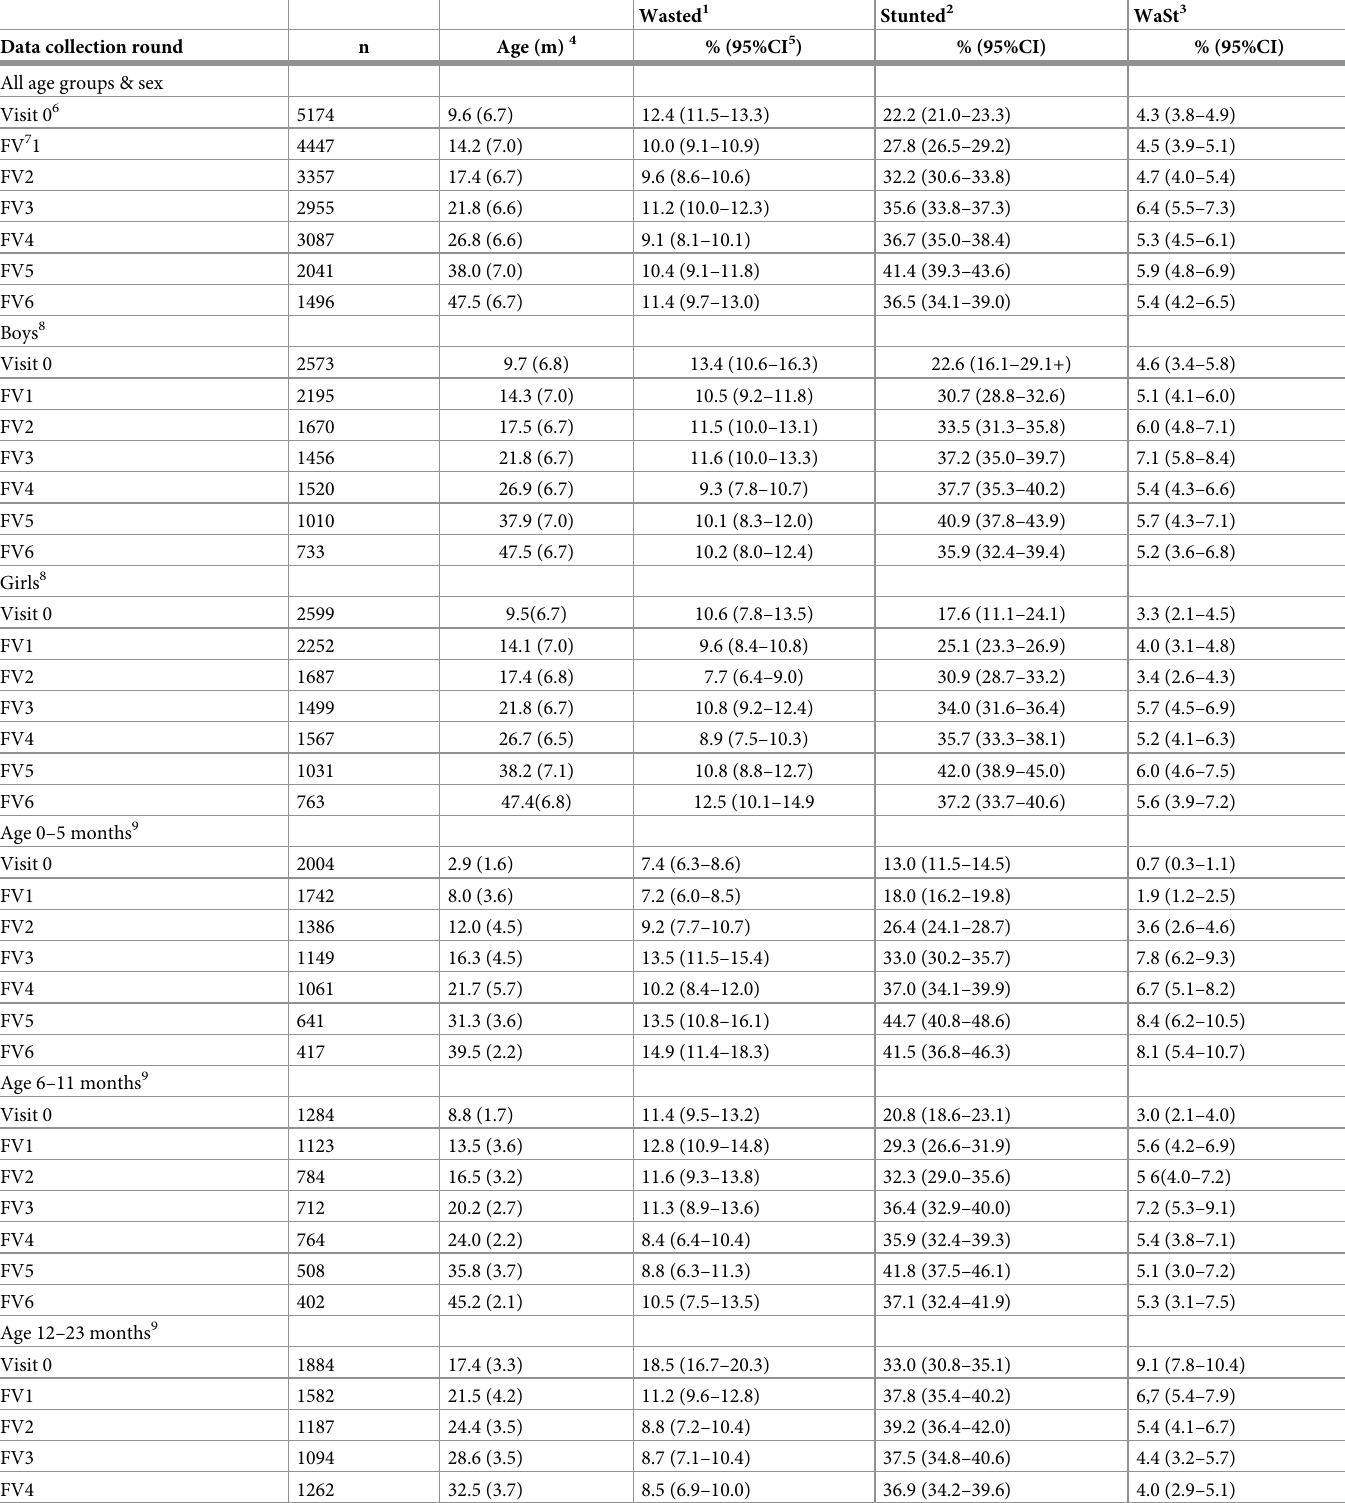
Table 2. Prevalence of wasting, stunting and concurrence of wasting and stunting at the different rounds of data collection by gender and age. Wasted 1 Stunted 2 WaSt